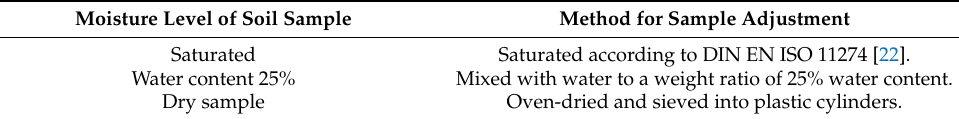
Table 1. Moisture levels of soil samples and method for sample adjustment.